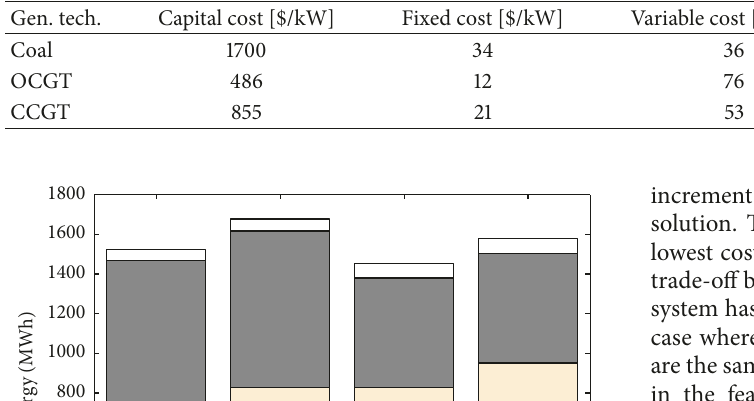
Table 3: Generation technologies cost and operational variables.